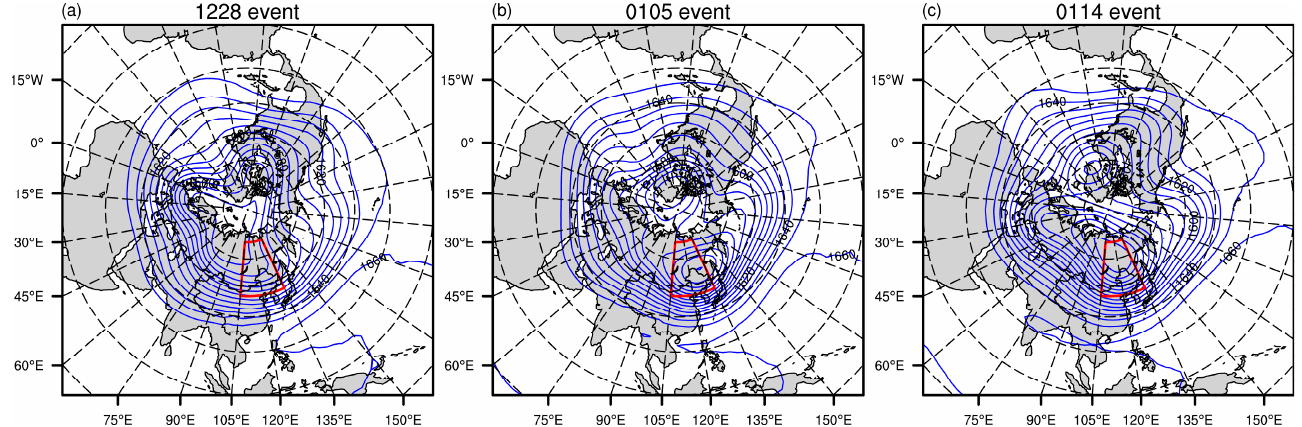
Figure 2. The mean potential height (100 hPa) distribution during the cold wave processes of ( a ) “1228”, ( b ) “0105”, and ( c ) “0114”. The red box represents the region between 40° N and 70° N and 105° E to 135° E.